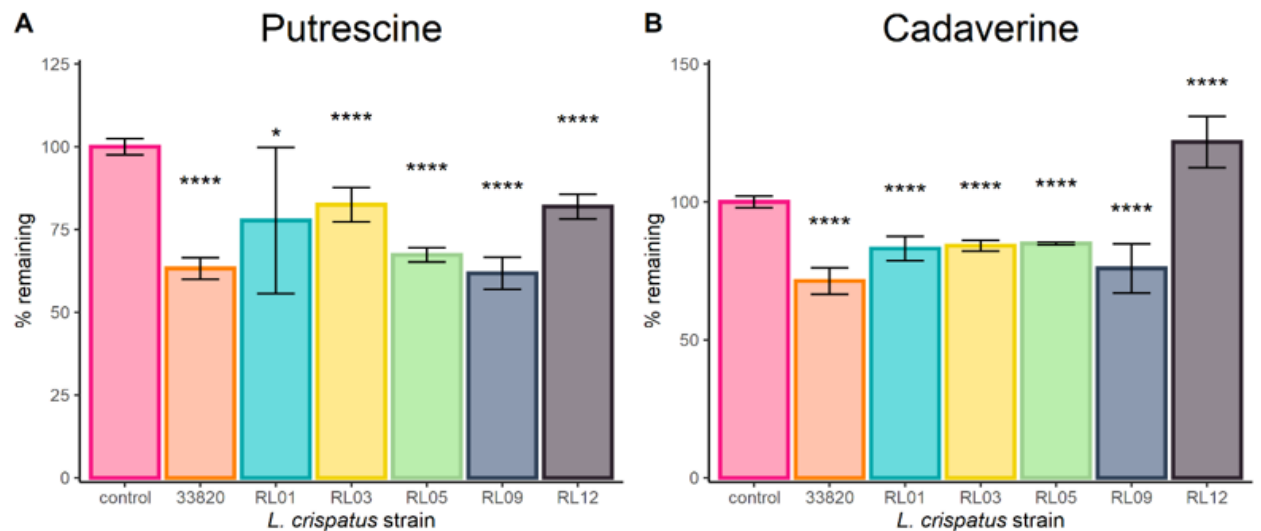
Figure 2. Metabolism of biogenic amines by different L. crispatus strains in amine VDMP. Control consists of amine VDMP only (no bacteria). Bar plots show the remaining concentration of ( A ) cadaverine and ( B ) putrescine, after 24 h of incubation with each strain of interest, One-way ANOVA with the Dunnet correction for multiple comparisons was used to calculate statistical significance (* p ≤ 0.05 and **** p ≤ 0.0001). Data are presented as means of 3 independent experiments with two technical replicates each ± 95% CI.